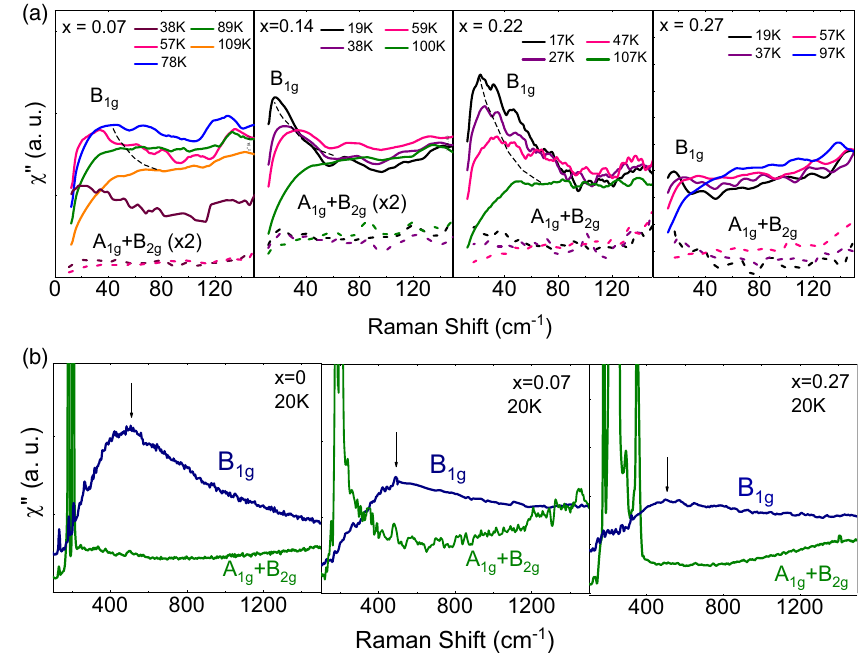
Fig. 2 Symmetry dependence of the Raman spectra. a Low energy part (on a linear scale) of the Raman spectra for two different symmetry channels B 1g (full lines) and A 1g + B 2g (dotted lines) and for x = 0.07, x = 0.14, x = 0.22, and x = 0.27. b symmetry channel dependence of the spectra over a wide energy range on a linear scale for x = 0, x = 0.07, and x = 0.27.